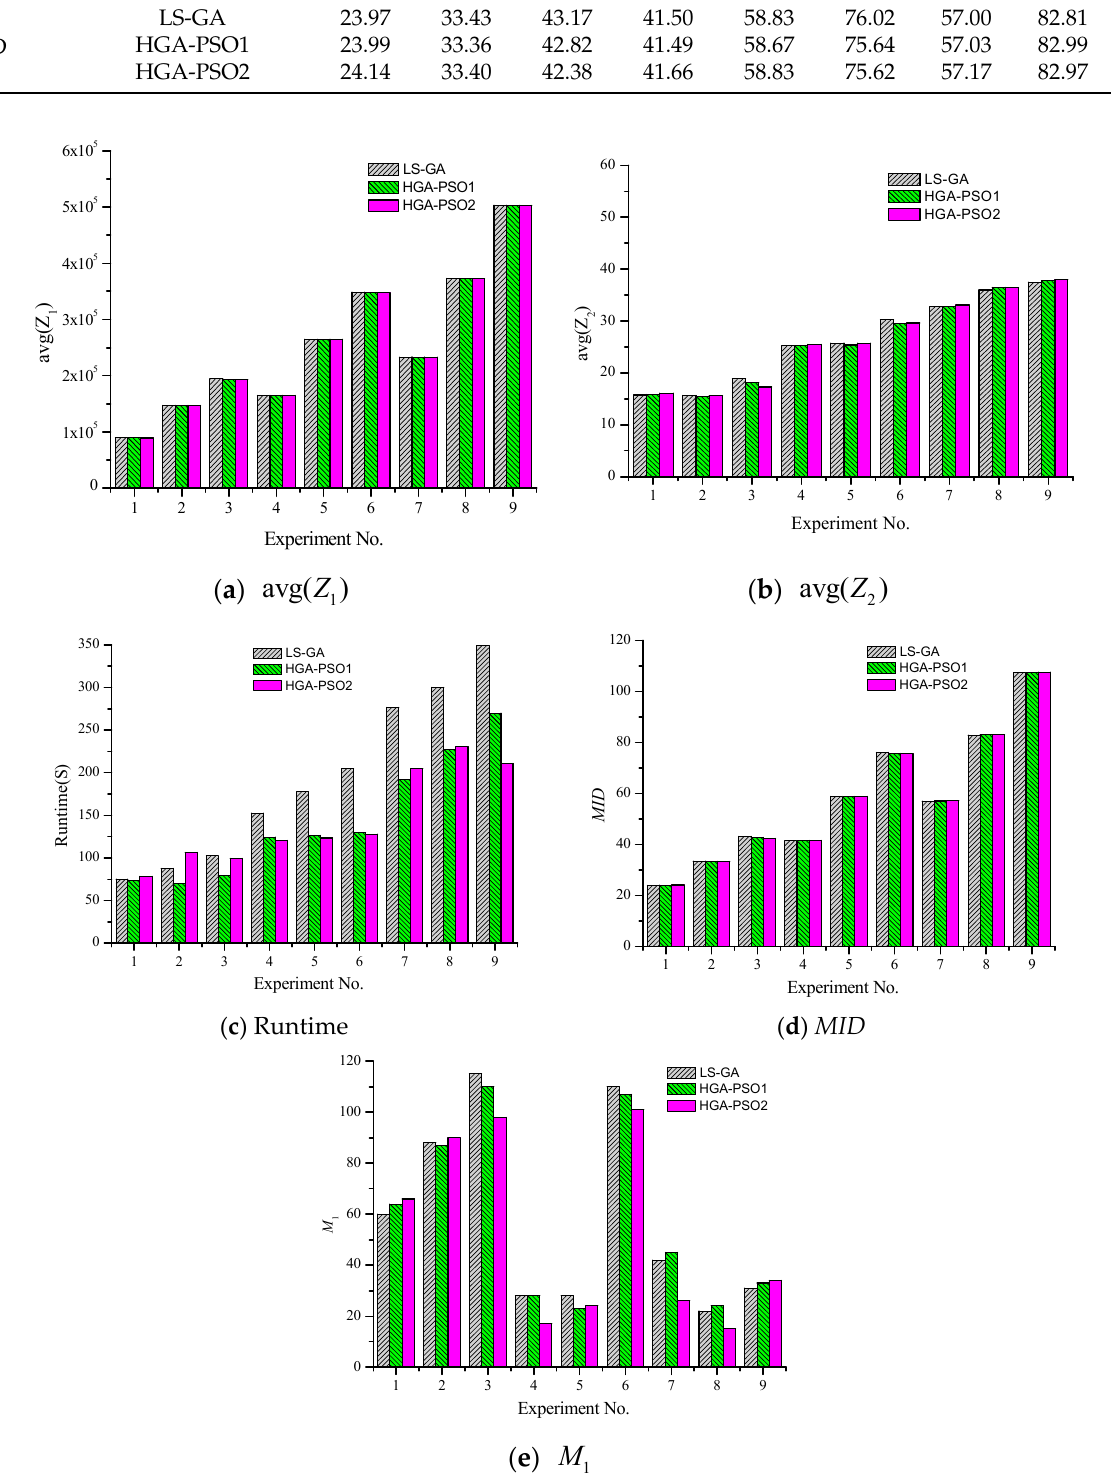
Figure 13. Comparative analysis of performance measures. Table 8. The results of performance measures.